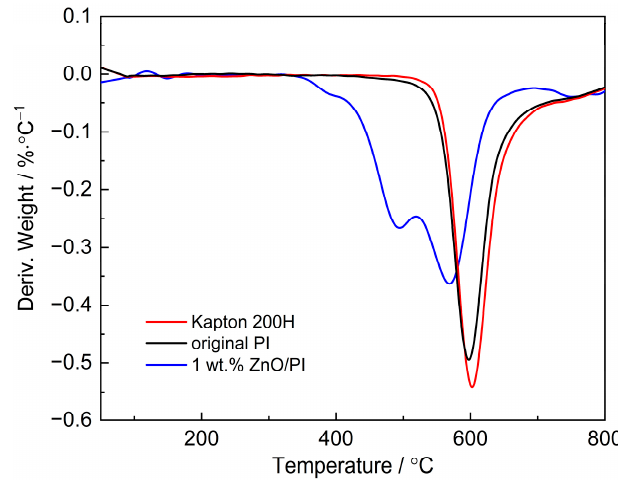
Figure 6. DTG curves of original PI and nano-ZnO/PI film.